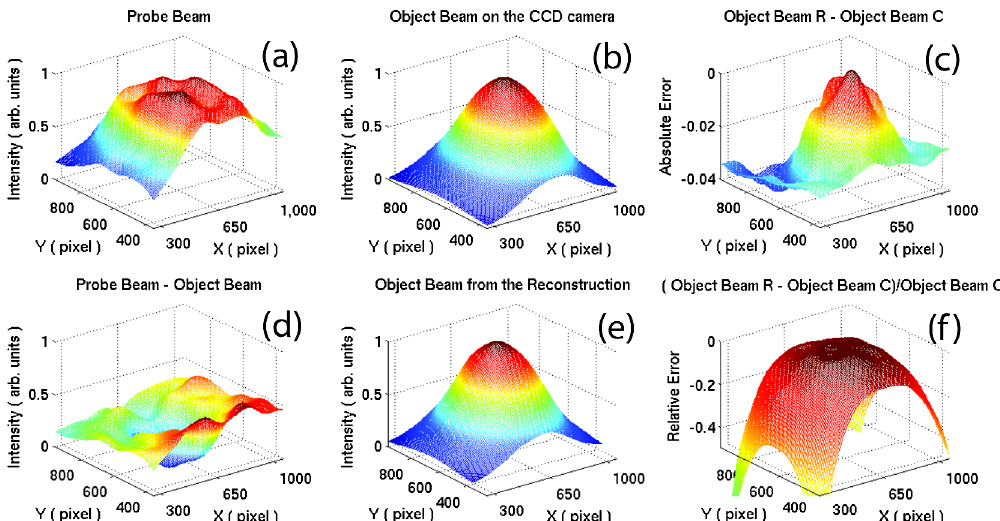
FIG. 10. The intensity profile of the ANDi fiber laser: (a) the normalized probe beam intensity; (b) the object beam intensity on the CCD camera; (c) the object beam intensity difference between retrieval process and the intensity on the CCD camera; (d) the probe beam intensity subtract from the object beam intensity; (e) the object beam intensity from retrieval process; (f) the relative error of the retrieval